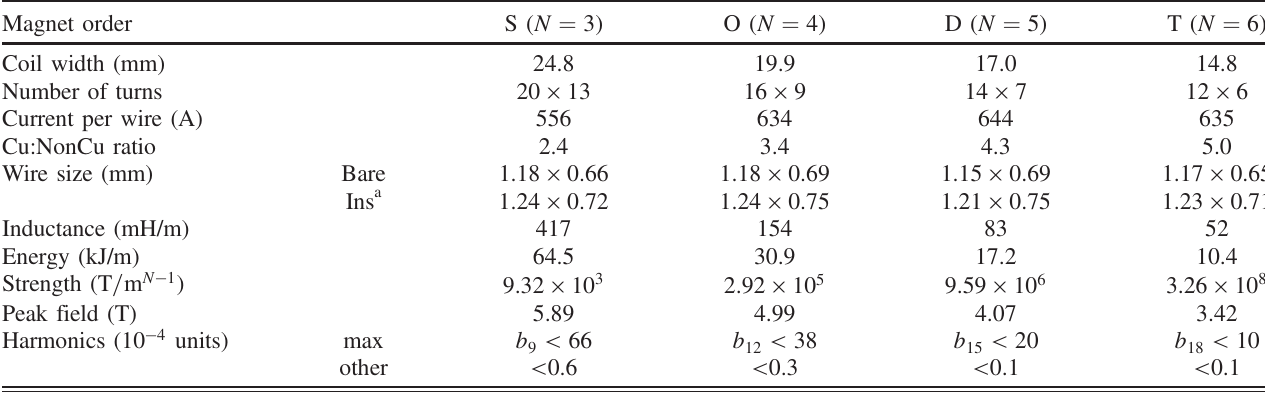
TABLE II. Optimal parameters obtained with DASH for cosine-theta magnets with iron poles ranging from sextupole to dodecapole. The number of turns and wire size are expressed as “ radial × azimuthal. ” Harmonics are expressed at reference radius r 0 ¼ 17 mm. Magnet order